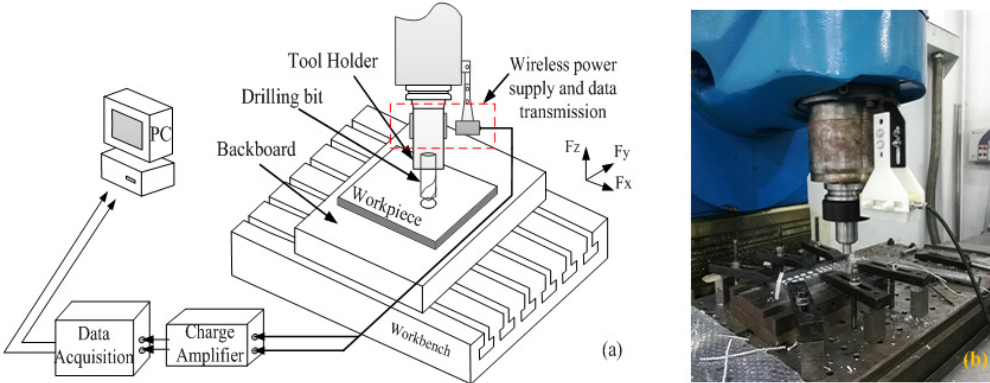
Figure 4. Data acquisition process: ( a ) data acquisition schematic diagram; and ( b ) data acquisition experimental set ‐ up.